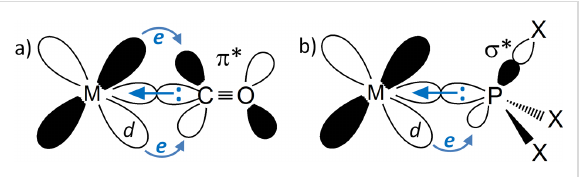
Figure 3: Synergistic backbonding model [53] for (a) M–CO and (b) M–PX 3 complexes.